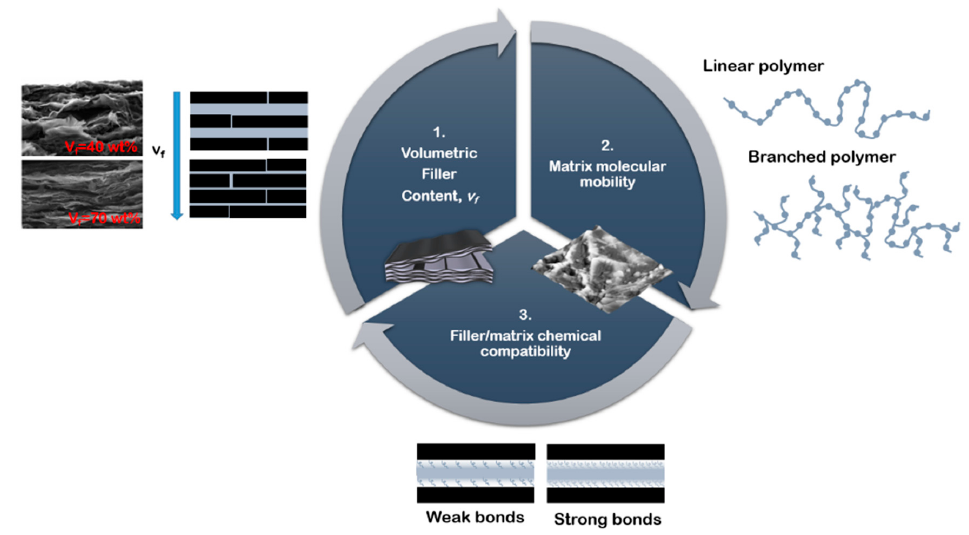
Figure 3. Parameters which influence the mechanical performances of composite with nano-lamellar reinforcement.